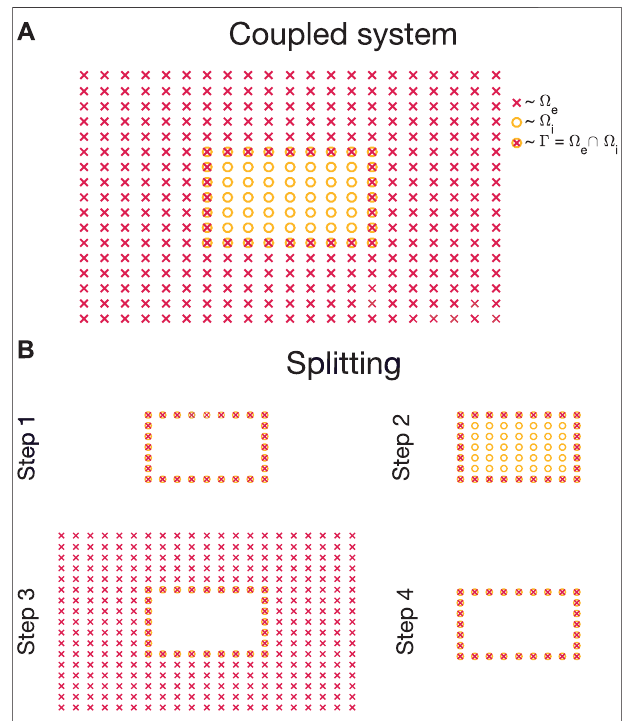
FIGURE 3 | Illustration of the computational mesh used in the coupled (A) andsplit (B) versionsofthe fi nitedifferencediscretizationoftheEMImodel. The mesh consists of three types of nodes; extracellular nodes marked by × , intracellular nodes marked by ○ , and membrane nodes marked by ⊗ .